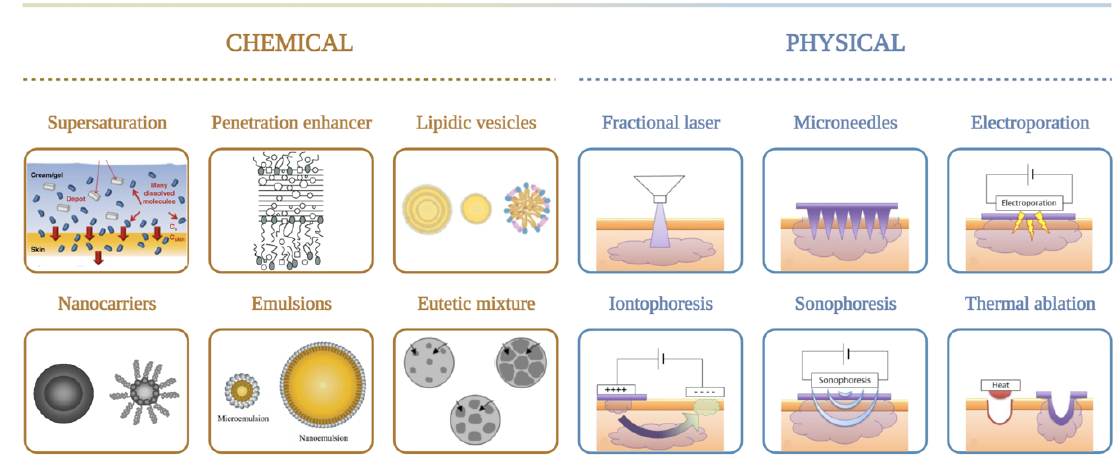
Figure 2. Current chemical and physical strategies to enhance transdermal drug delivery of photodynamic therapy.